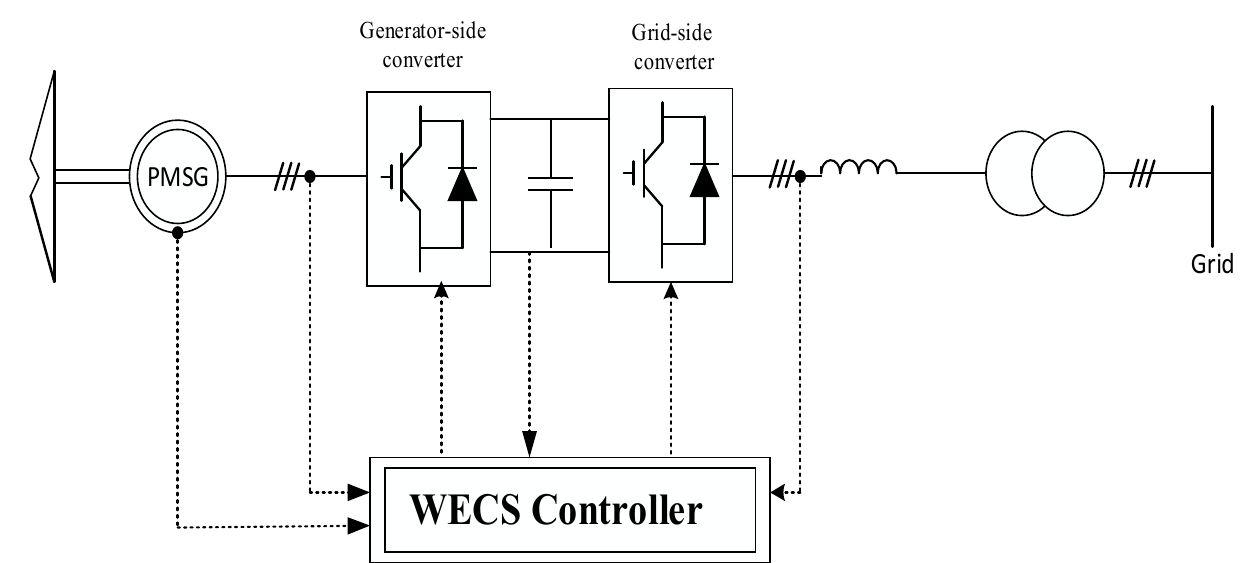
Figure 1. Kinetic to electric energy conversion system based on direct-driven permanent magnet synchronous generator (PMSG) topology.